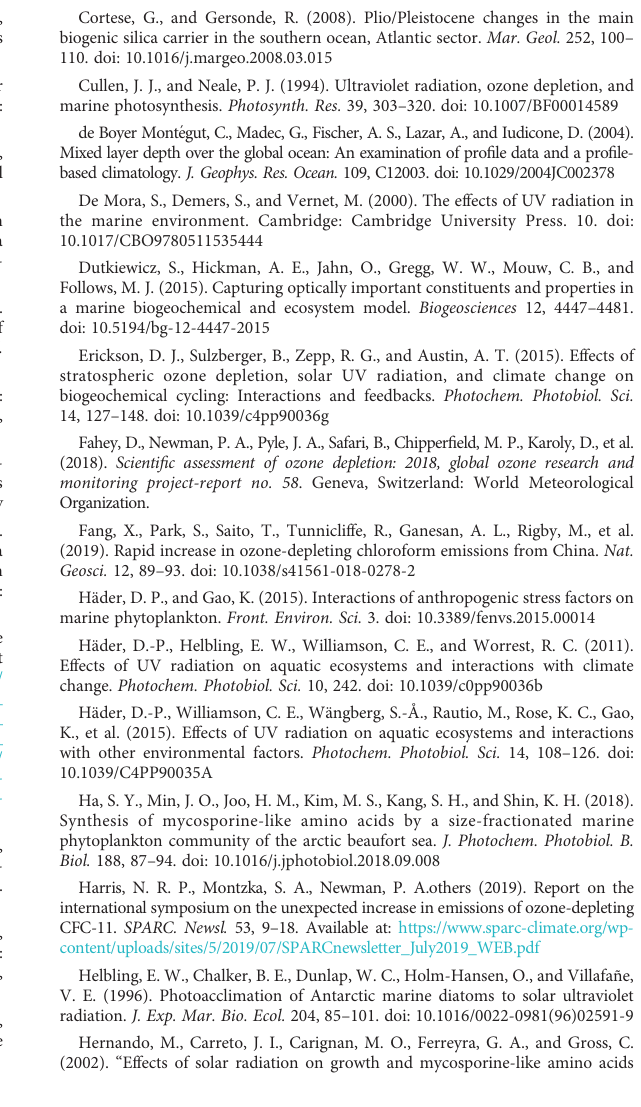
SUPPLEMENTARY FIGURE 2 Representative HPLC chromatograms of MAA samples from extracts. (A) North of the PF, latitude -55.38°S, longitude -174.16°W, and (B) South of the PF, latitude -67.72°S, longitude -134.12°W. MAAs identi fi ed in the chromatogram were 1) shinorine, l max 332, retention time 5.4 min; 2) palythine l